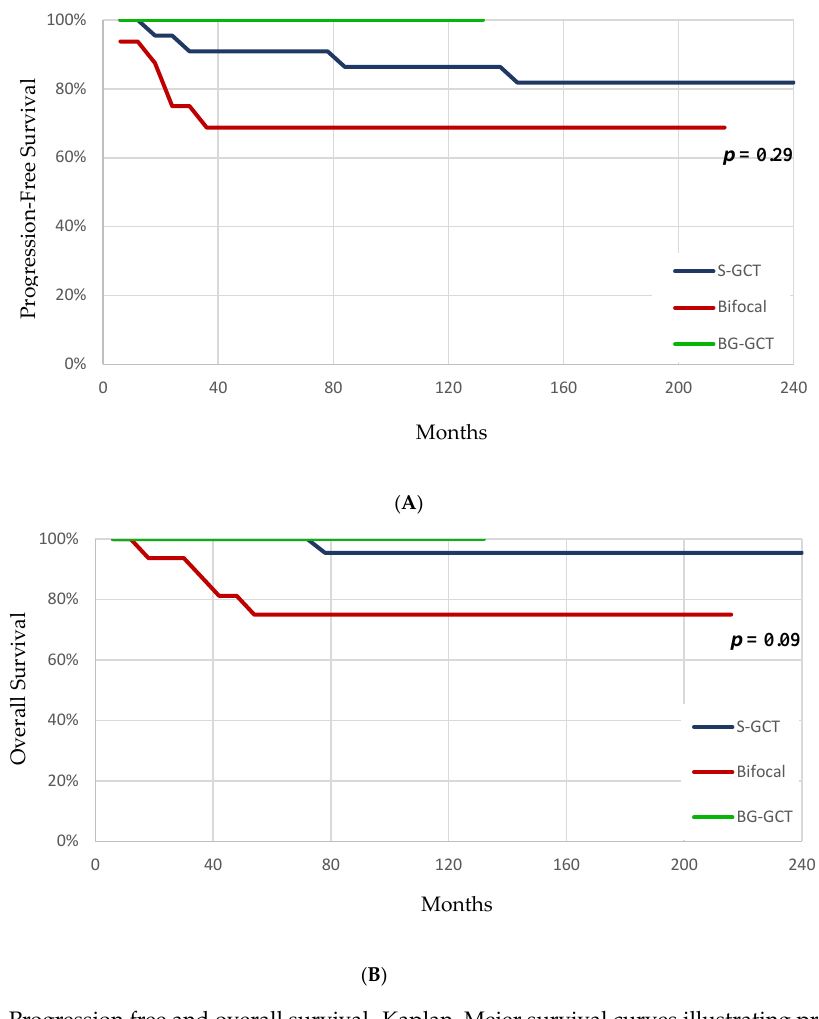
Figure 9. Progression free and overall survival. Kaplan–Meier survival curves illustrating progression free survival ( A ) and overall survival ( B ) for patients with S-GCT, bifocal, and basal ganglia (BG)-GCT. Children with bifocal tumors trended toward worse overall survival versus the other groups ( p = 0.09).